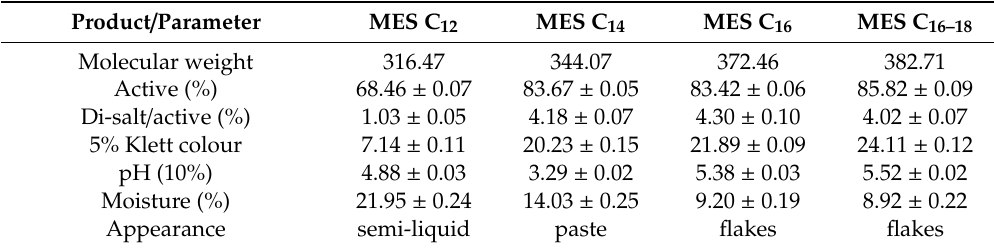
Table 7. Technical specifications of MES with di ff erent carbon chain lengths produced from MPOB’s MES